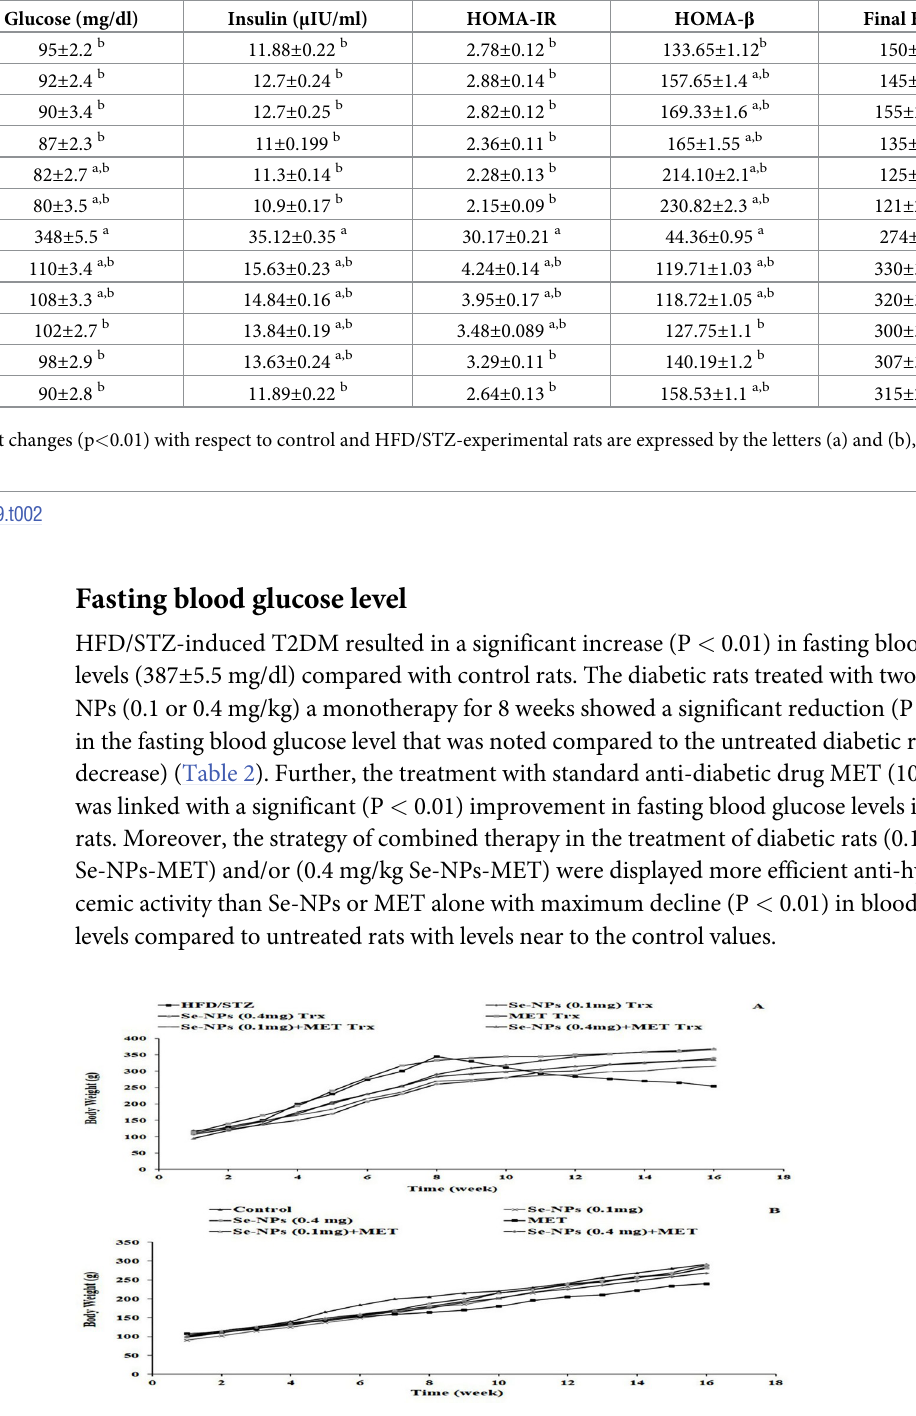
Fig 4. Changes in body weights in induced and control groups after HFD/STZ induction and treatments. A: Body weights of HFD/STZ-induced rats and after Se-NPs and MET treatment. B: Body weights of control groups that take a normal